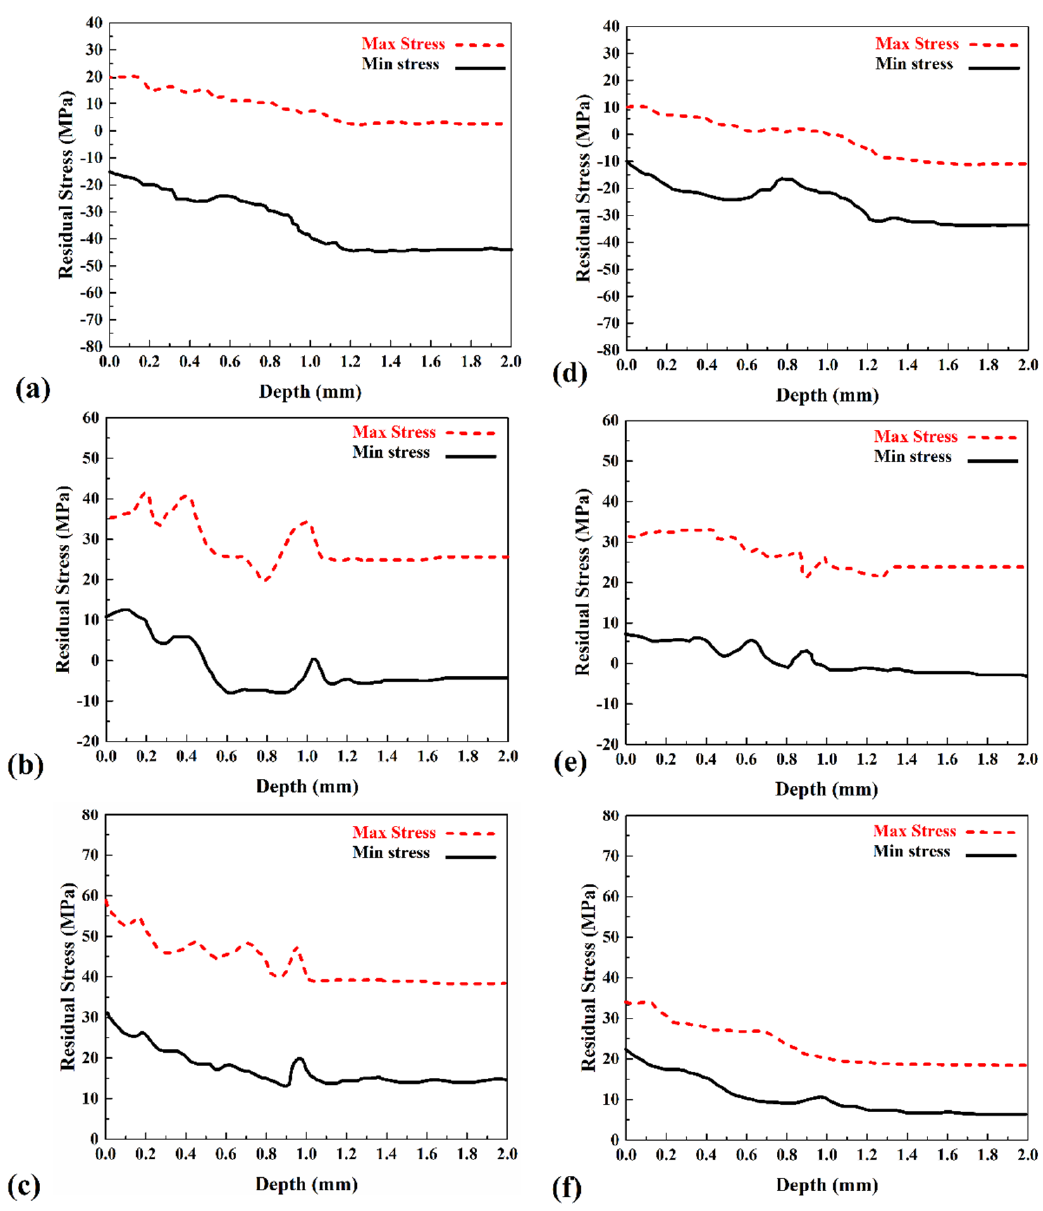
Figure 8. Calculated residual stress in the FSW sample by ( a ) rosette (I), ( c ) rosette (II), and ( e ) rosette (III). Calculated residual stress in the UFSW sample by ( b ) rosette (I), ( d ) rosette (II), and ( f ) rosette (III).